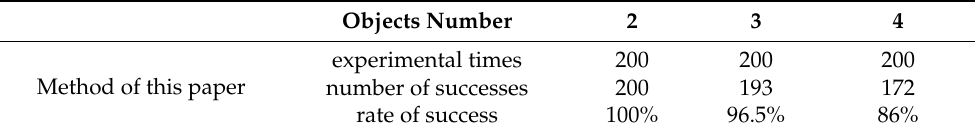
Table 5. Threshold of point cloud variance on target surface(cm 2